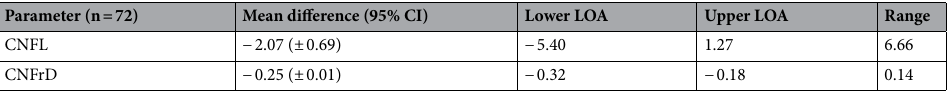
Table 3. Bland–Altman analysis: Voxeleron deepNerve versus ACCMetrics. CI confidence interval, CNFL corneal nerve fiber length, CNFrD corneal nerve fractal dimension, LOA limits of agreement.